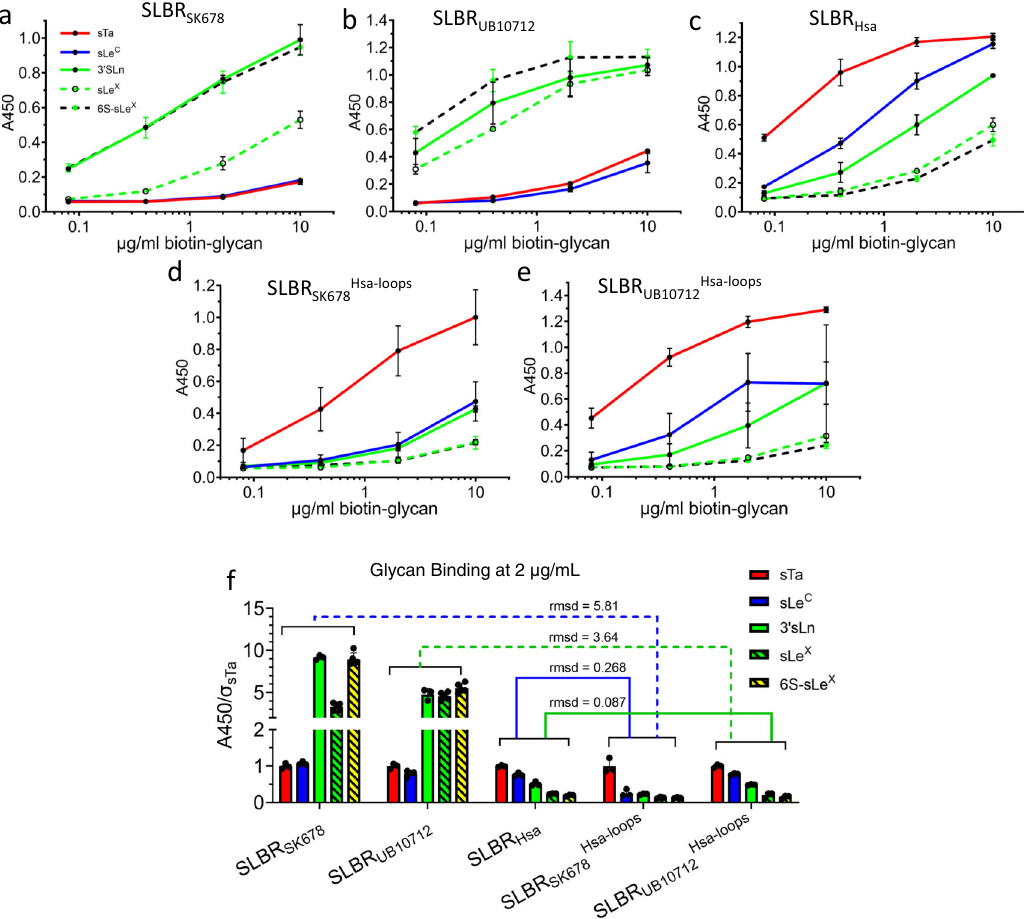
Fig. 6 Chimeragenesis of SLBR Hsa and its close homologs. Dose-response curves of a wild-type GST-SLBR SK678 , b wild-type GST-SLBR UB10712 , and c wild-type GST-SLBR Hsa to fi ve selected ligands. Dose-response curves of the chimeras d GST-SLBR SK678 Hsa-loops and e GST-SLBR UB10712 Hsa-loops which contain the CD, EF, and FG loops of SLBR Hsa . a – e data points represent the mean value and bars represent the standard deviation. f Quantitation of bound glycans at a concentration of 2 µ g/ml to parent and chimeric SLBRs. Individual datapoints are shown in black dots with the bar height and the thin black bars representing the mean and standard deviation. The y axis is the absorbance at 450nm of each sugar normalized to the absorbance of sTa to each SLBR. Root mean square deviation (rmsd) values were calculated from the normalized average signal of each glycan to compare the similarity of binding pro fi les between SLBRs. This identi fi es that both GST-SLBR SK678 Hsa-loops and GST-SLBR UB10712 Hsa-loops bind to sTa more strongly than the parent SLBRs. In addition, the chimeric SLBRs now have a